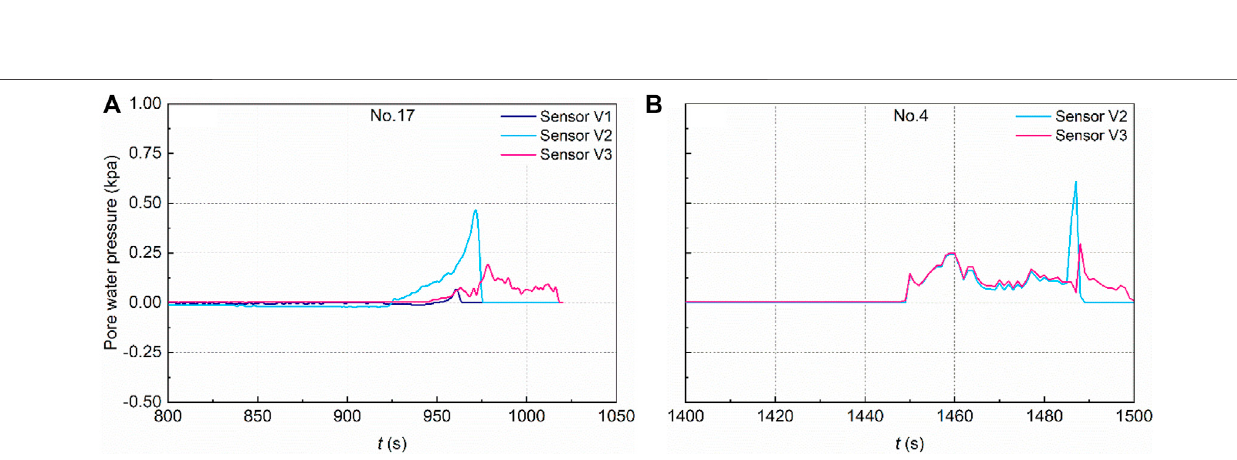
Frontiers in Environmental Science |